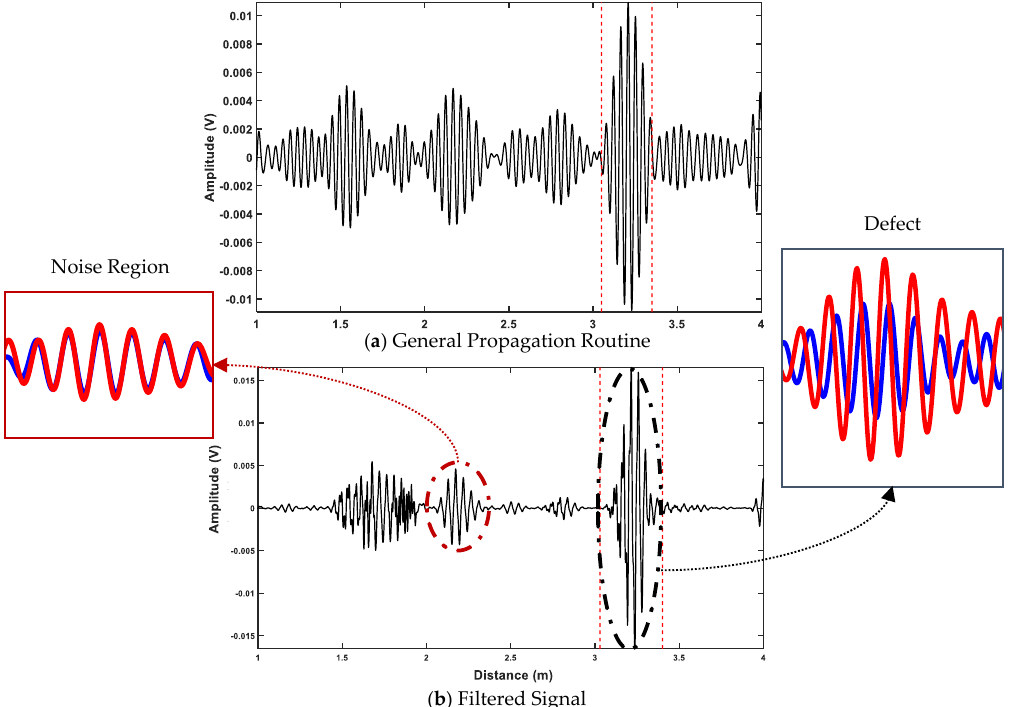
Figure 19. The result of ( a ) general propagation routine vs ( b ) filtered signal with their corresponding inputs (blue and red lines) of noise (left side) and defect (right side) with the excitation frequency of 38 kHz gathered from an experimental pipe with defect size of 3% CSA.